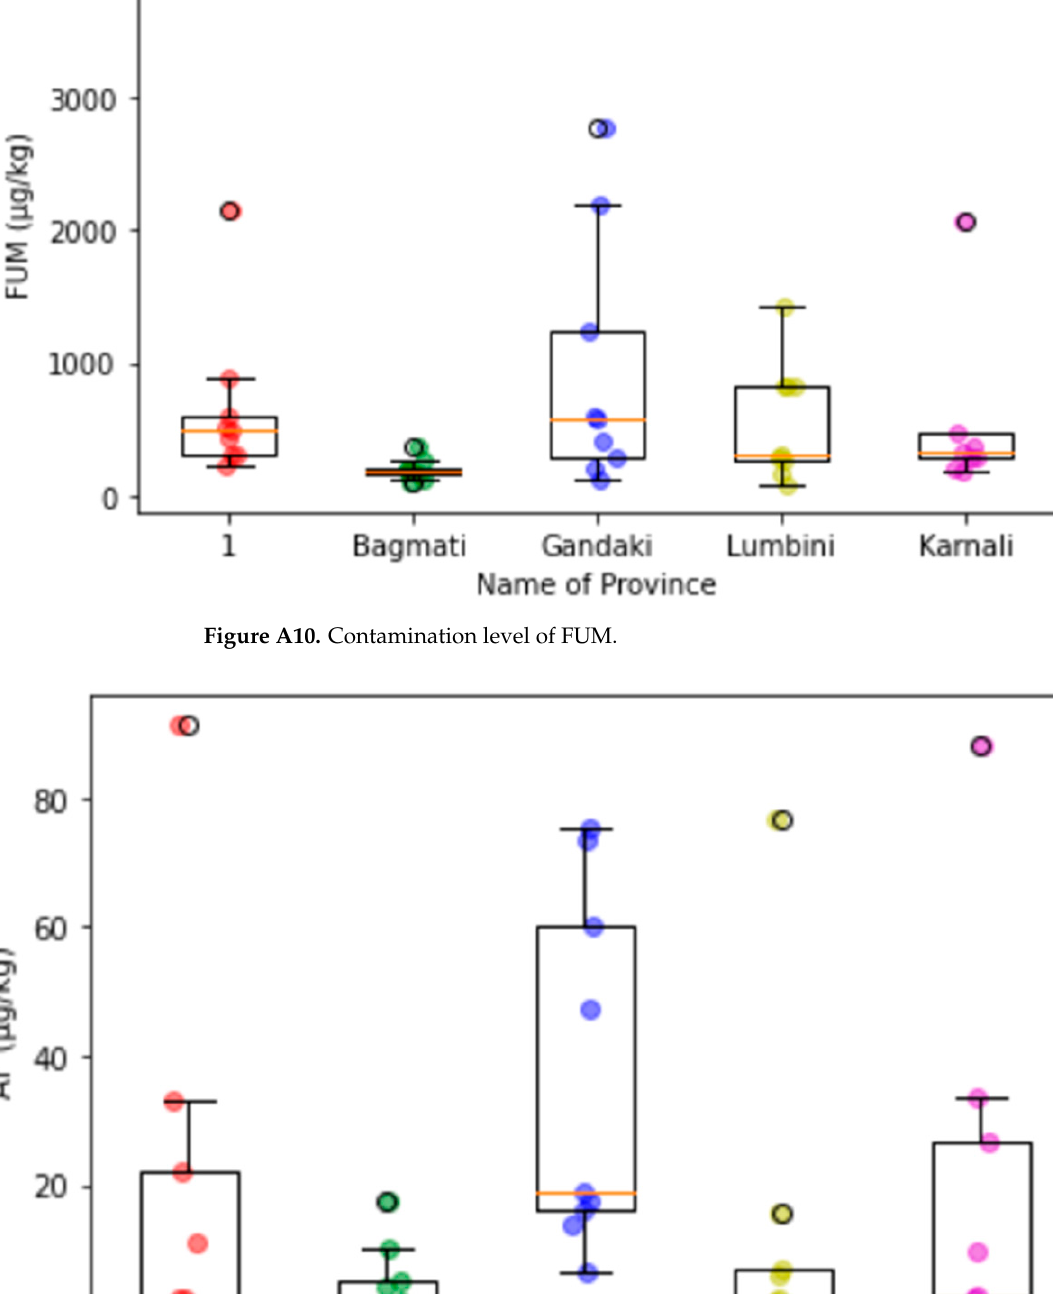
Figure A9. Contamination level of OT.